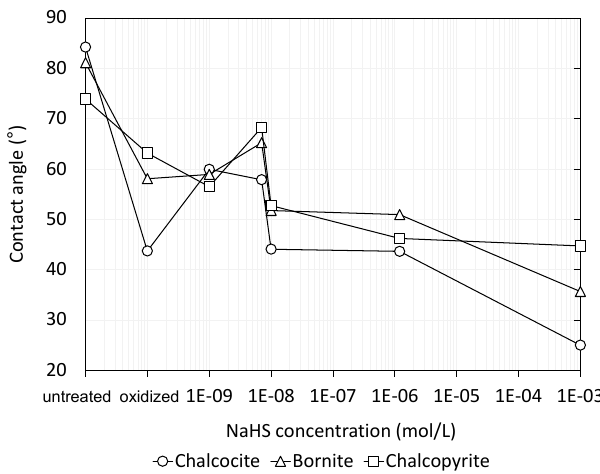
Figure 2. The results of contact angle measurements on untreated, oxidized, and NaHS-treated chalcocite, bornite, and chalcopyrite at several NaHS concentrations.